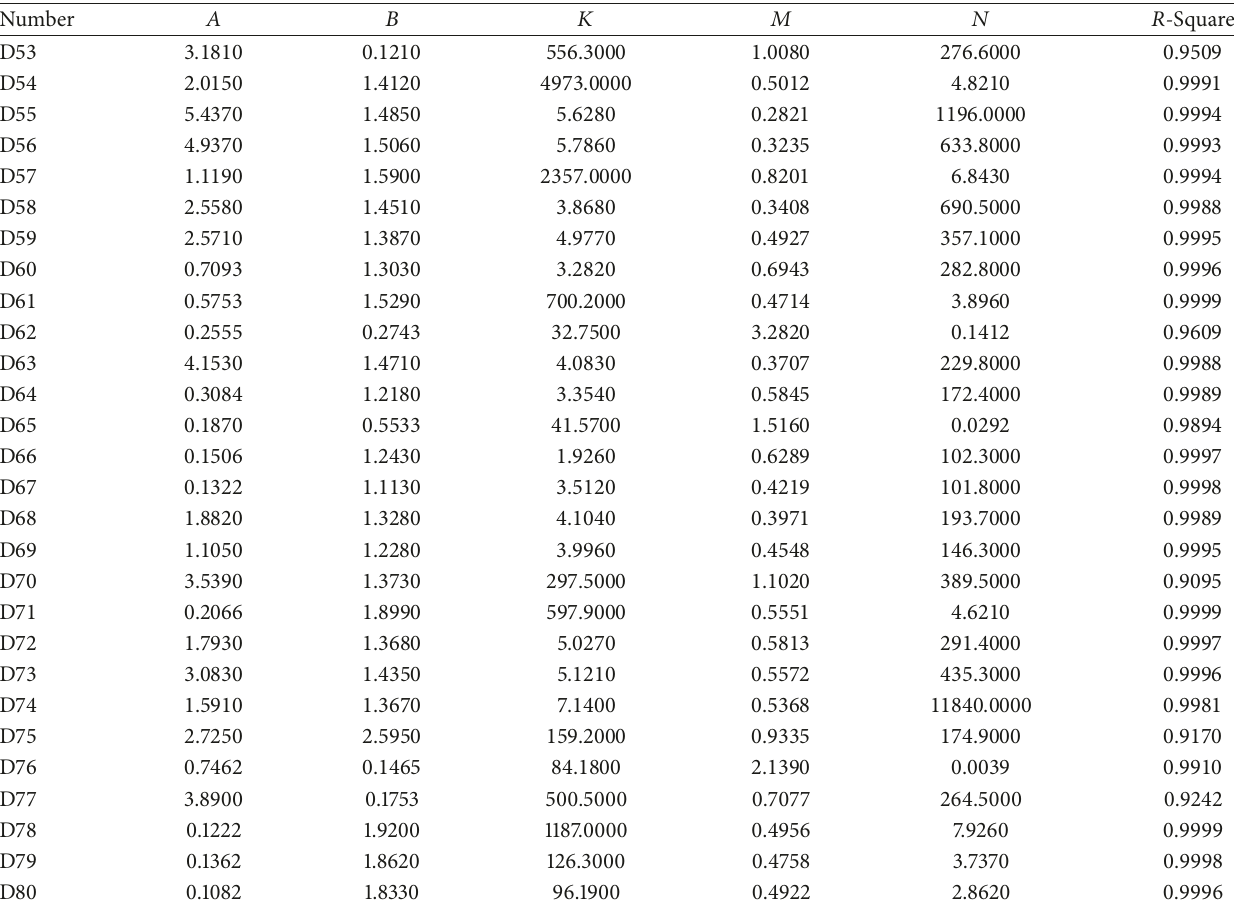
Figure 2 points out that if we only apply Langmuir isotherm to shale adsorption in low relative pressure